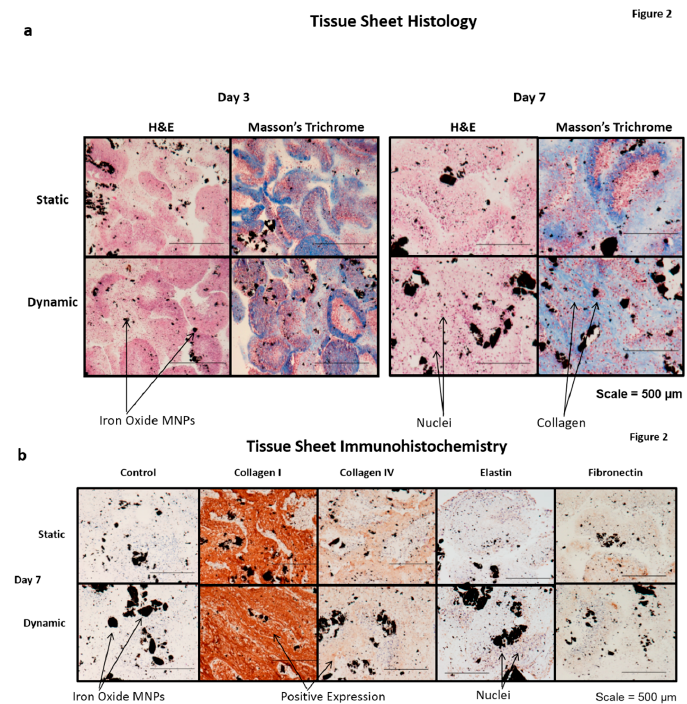
Figure 1. Immunohistochemistry staining of spheroids over time. Spheroids containing iron oxide MNPs and spheroids without MNPs were immunohistochemically examined for collagen I, collagen IV, elastin, and fibronectin after a 40-day incubation period in cell culture media. Spheroids with and without MNPs were also incubated in media supplemented with ascorbic acid, which is a known stimulant of collagen production. Each spheroid type demonstrated positive stains for each ECM marker when compared to their respective controls. A preferential cellular organization, as illustrated in the spherical geometry of the spheroids was observed (black = iron oxide, brown = positive stain).